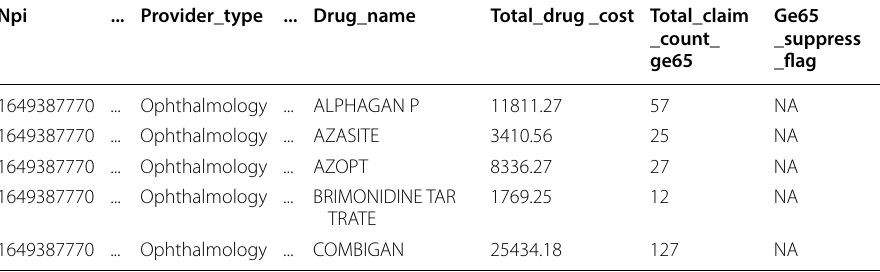
Table 2 Sample of Part D dataset